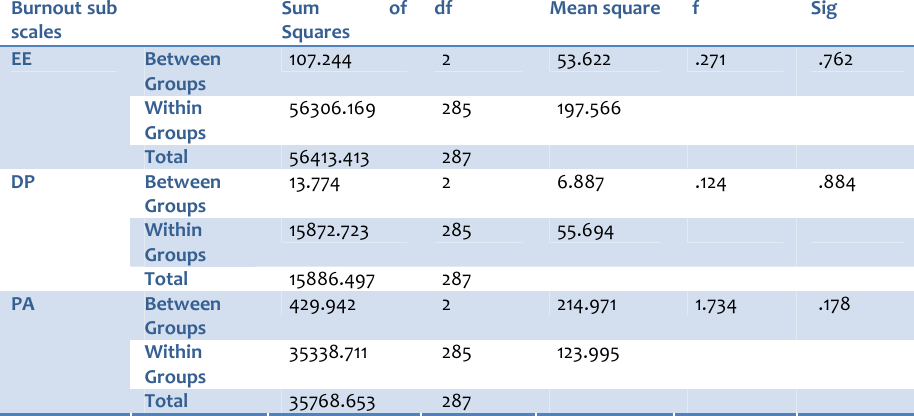
Table 12: Respondents’ Grade Level of Teaching and Mean Scores of burnout